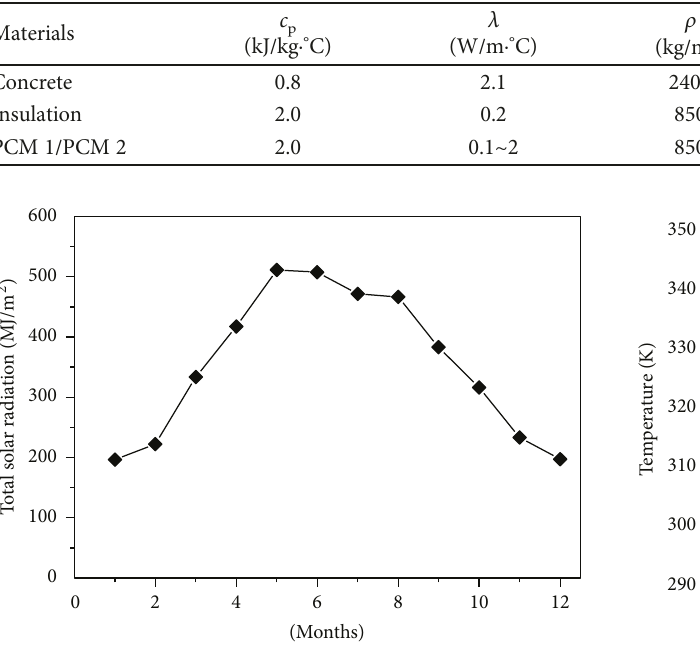
Table 1: Thermo-physical properties of the wallboard materials [18].